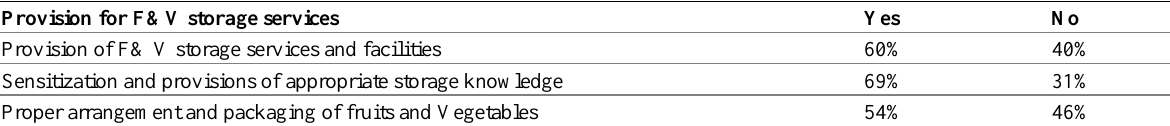
Table 3: Summary of Storage Services for Fruits and Vegetables